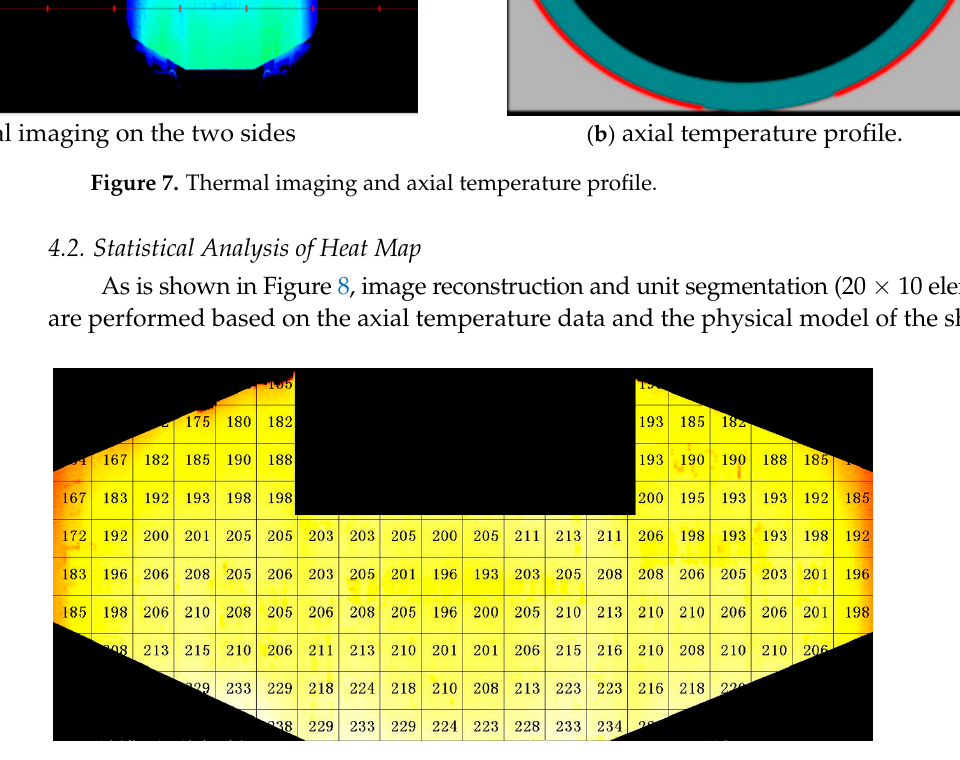
Figure 8. Image reconstruction of torpedo car.